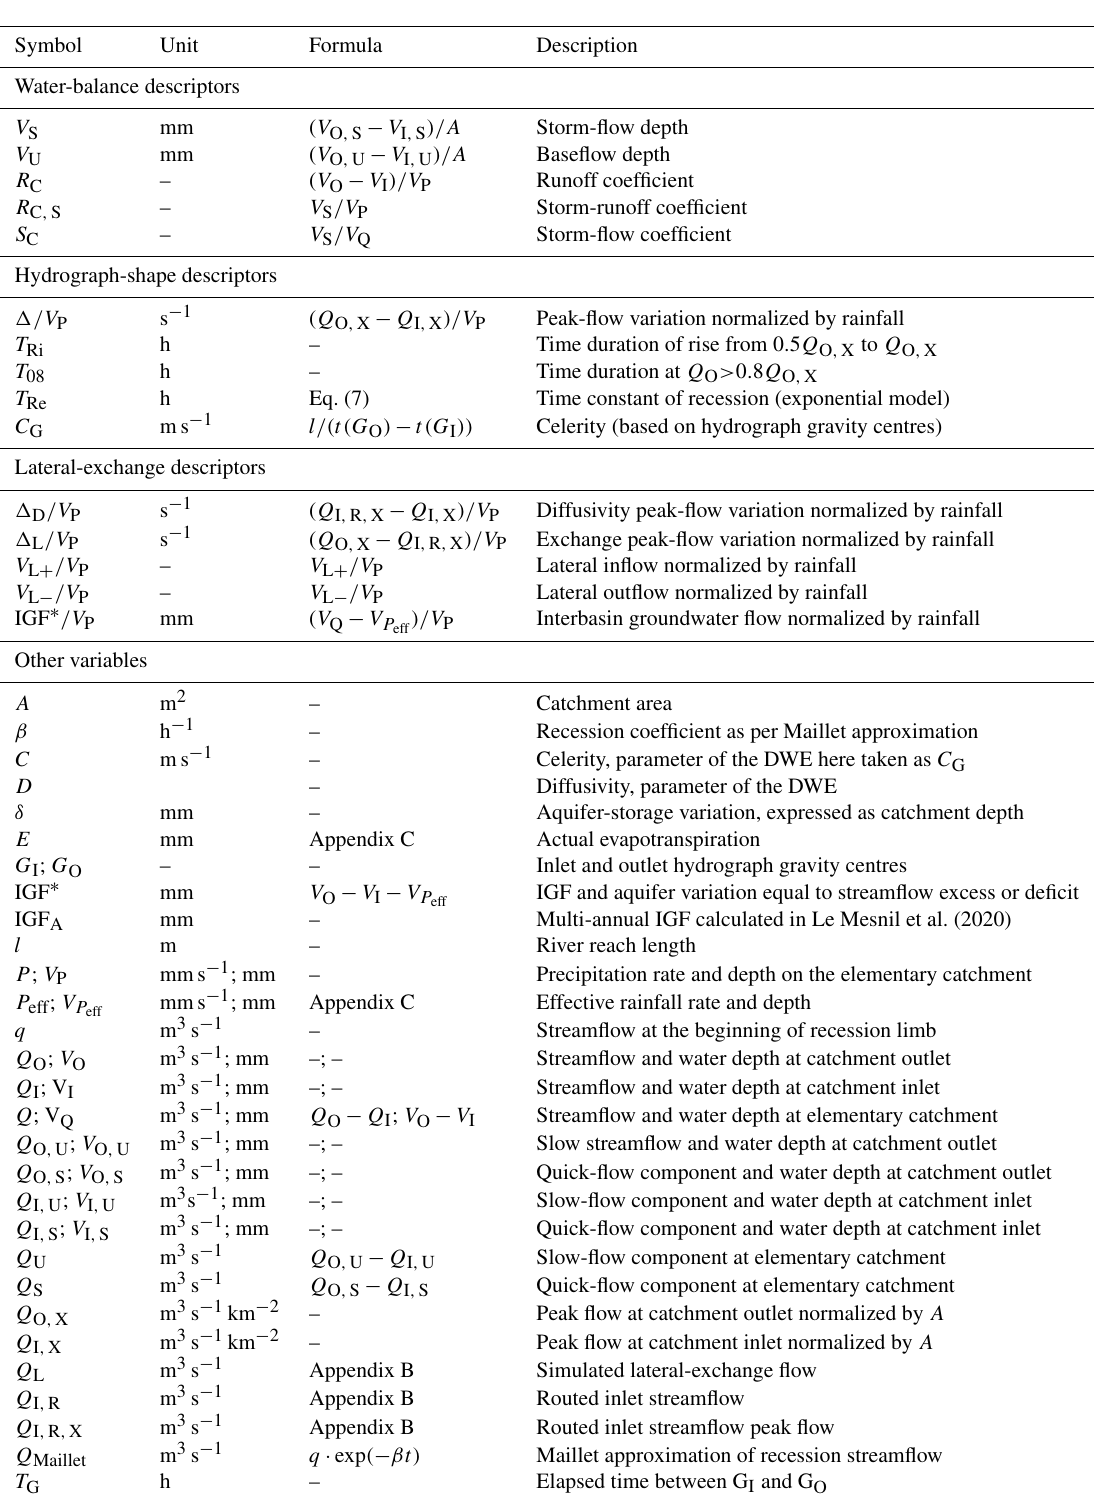
Table D1. List of